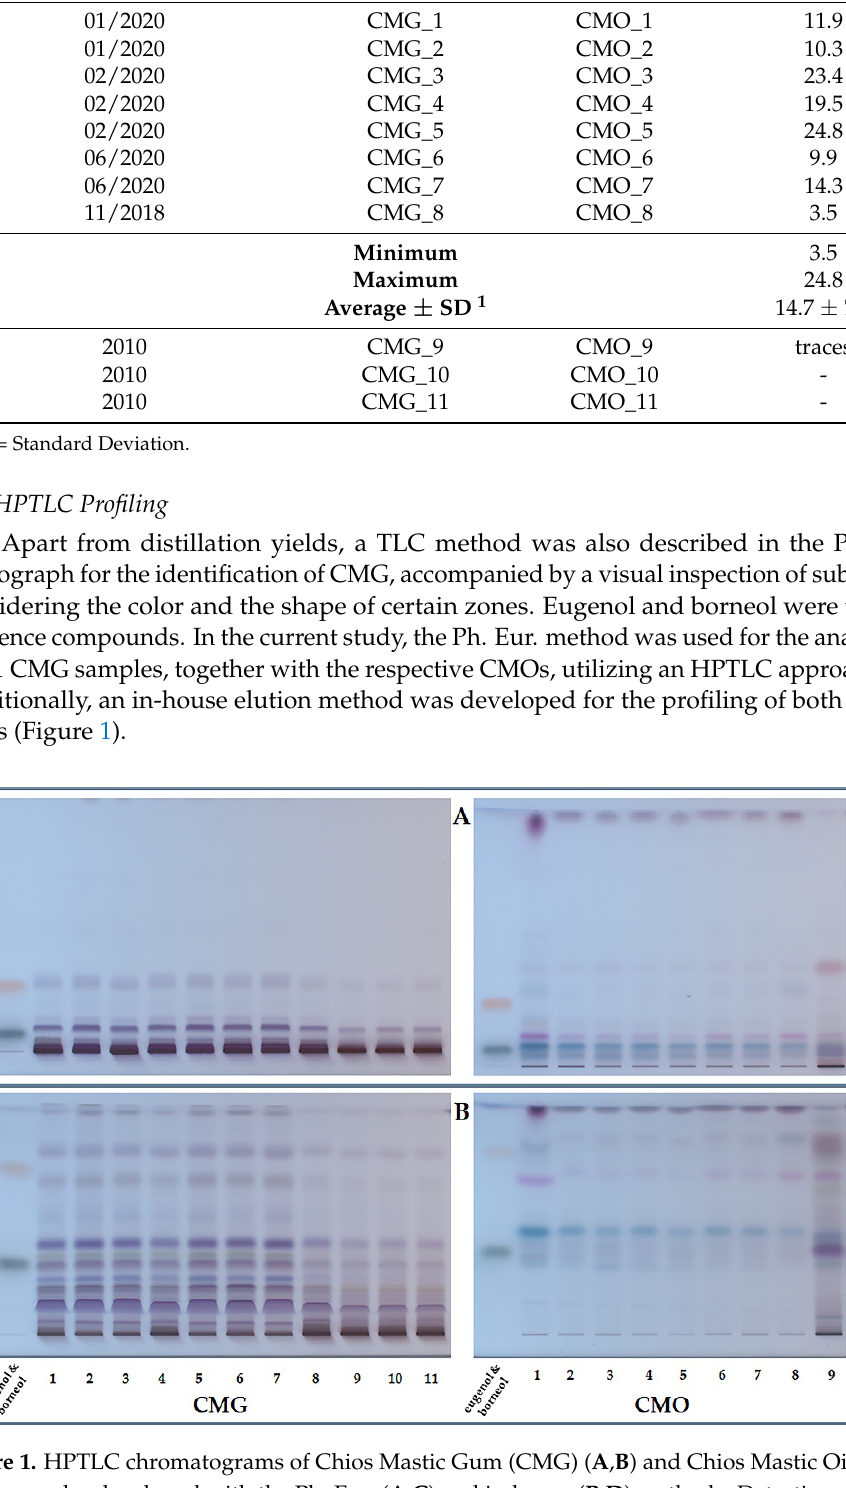
Figure 1. HPTLC chromatograms of Chios Mastic Gum (CMG) ( A , B ) and Chios Mastic Oil (CMO) ( C , D ) samples developed with the Ph. Eur. ( A , C ) and in-house ( B , D ) methods. Detection at visible light after spraying with vanillin reagent.